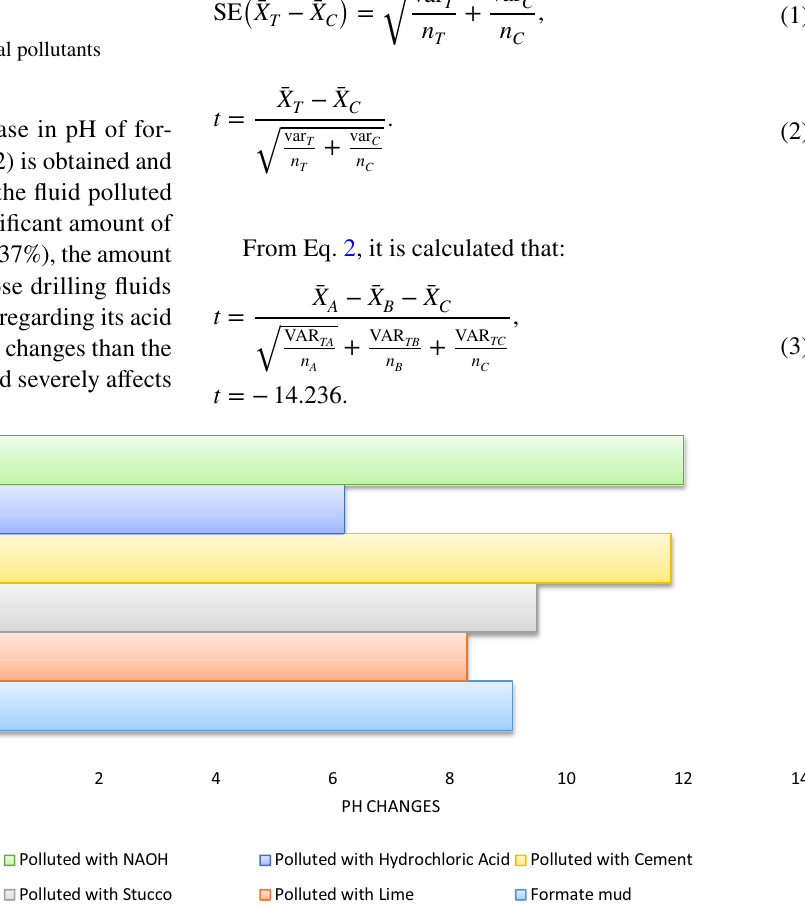
Fig. 4 Fluid loss changes in the presence of several pollutants